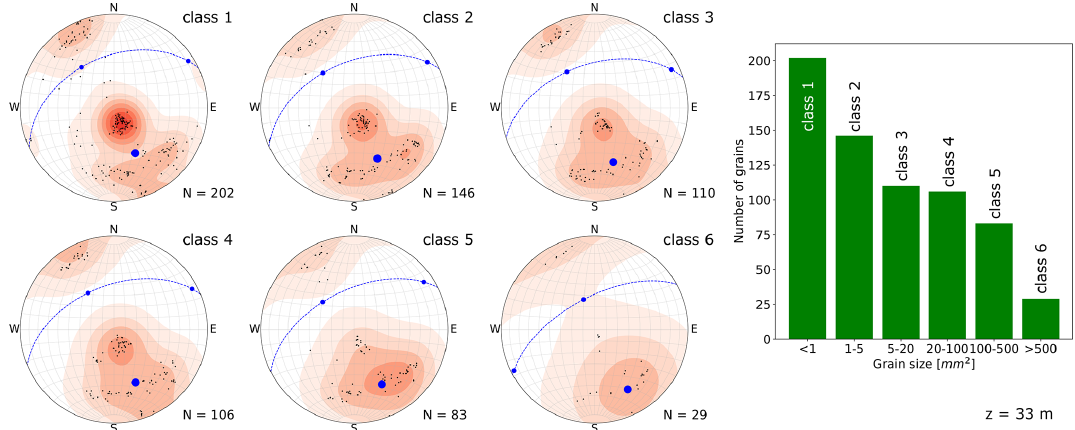
Figure 9. Stereo-plots (lower-hemisphere Schmidt equal-area projection) with the colour coding the same as in Fig. 5. Each plot represents a grain size class as indicated in the upper right corner. The number of grains per class is specified for each plot. The calculated eigenvectors for the c -axis distribution are shown as blue dots (the normal plane for the largest eigenvector is shown as a dashed blue line). Right column: histogram showing the number of grains per class.